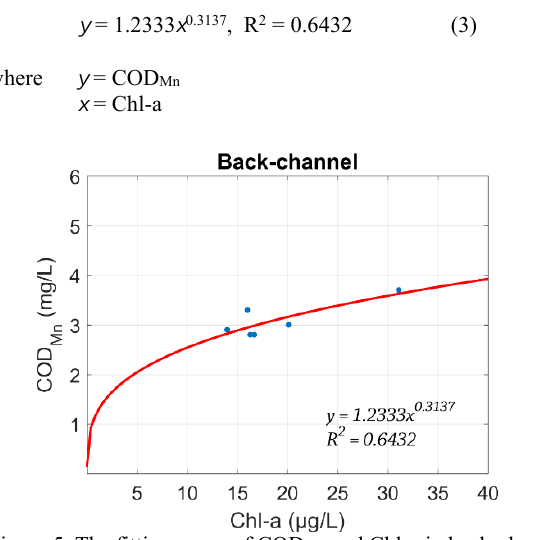
Figure 5. The fitting curve of COD Mn and Chl-a in back-channel